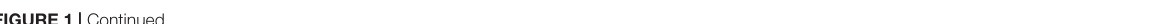
FIGURE 1 | Continued each amino acid at that position. Color code of amino acids: blue, positively charged (KR) residues; red, hydrophobic (AFILMV) and amphipathic (WY) residues; black, all other amino acids. The underlined G residue in the NCR-like peptides marks the beginning of the γ -core motif. (B) The mode of actions of cationic NCRs based on the example of NCR247 (Created with BioRender.com). NCRs can interact with the bacterial membranes and enter the cytosol with or without pore formation or cause membrane damages and cell lysis. Intracellularly NCRs provoke global transcriptional changes and interact with numerous bacterial proteins that collectively affect essential cellular functions. The framed proteins BacA, HrrP, SMc03872, and polysaccharides EPS and LPS protect the symbiotic bacterium partner from the killing action of